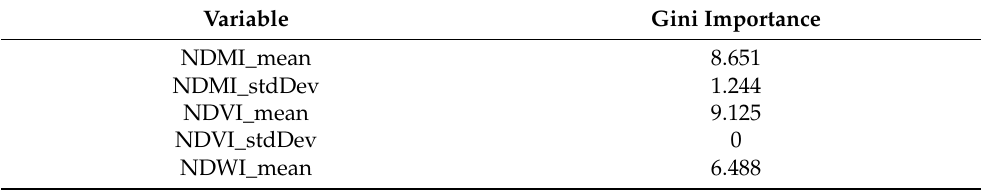
Table 9. Relative importance of the variables for the model classifying intact and not-intact pixels for Shark River